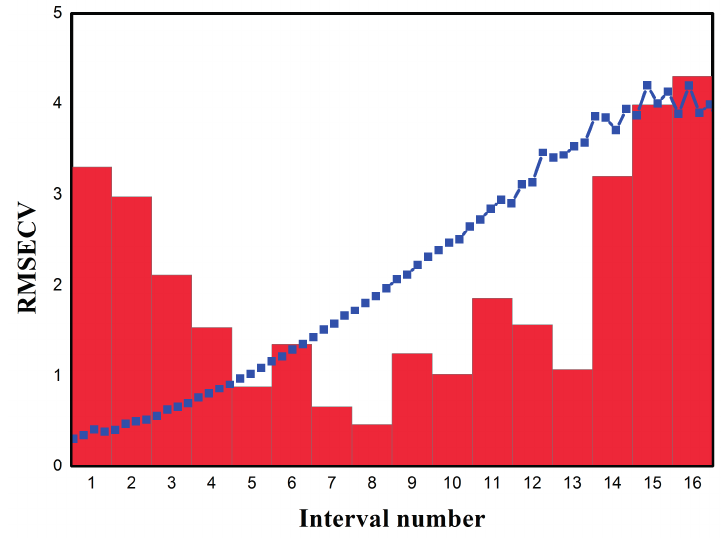
Figure 5. The iPLS results for the THz spectra data. The columns indicate the RMSECV in each subinterval, and the mean absorption spectrum of the wheat samples is overlaid on the plot.